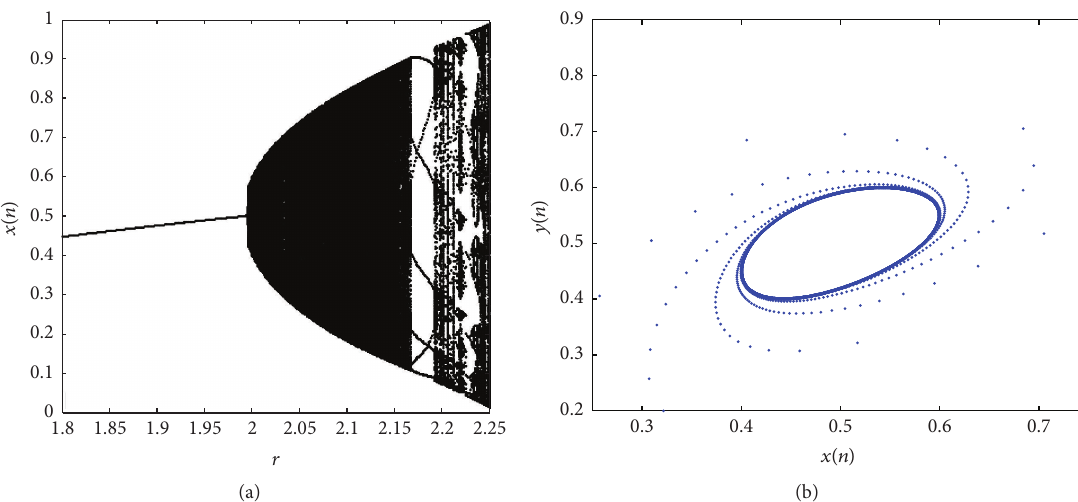
Figure 1: (a) Bifurcation diagram of model (5) with bifurcation parameter 𝑟 covering [1.8, 2.25] and (b) phase portrait corresponding to bifurcation parameter 𝑟 = 2.01 . The initial values are [𝑥(0) = 0.2, 𝑦(0) = 0.2] .